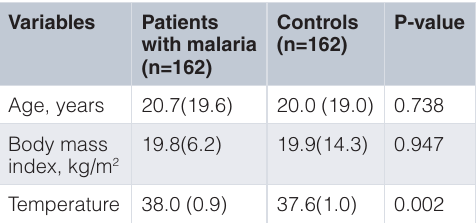
Table 1. Comparing the mean (±SD) age, BMI and body temperature between patients with malaria and negative